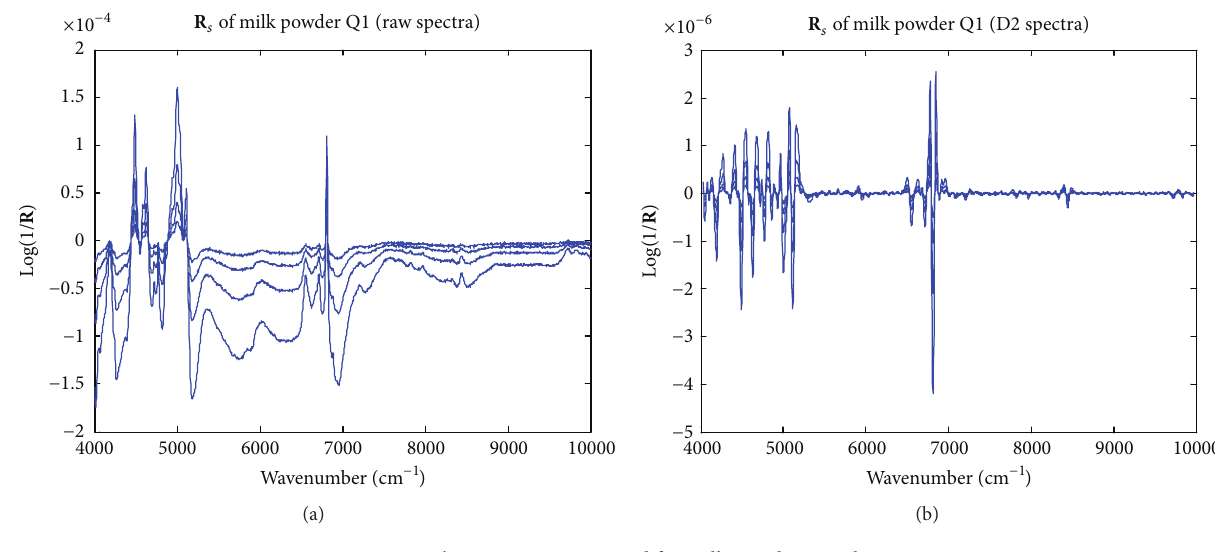
Figure 3: The R 𝑠 matrix computed for milk powder sample